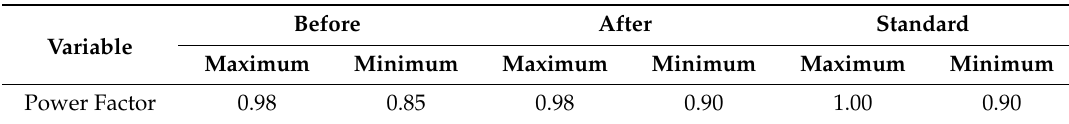
Table 8. Comparison of power factor